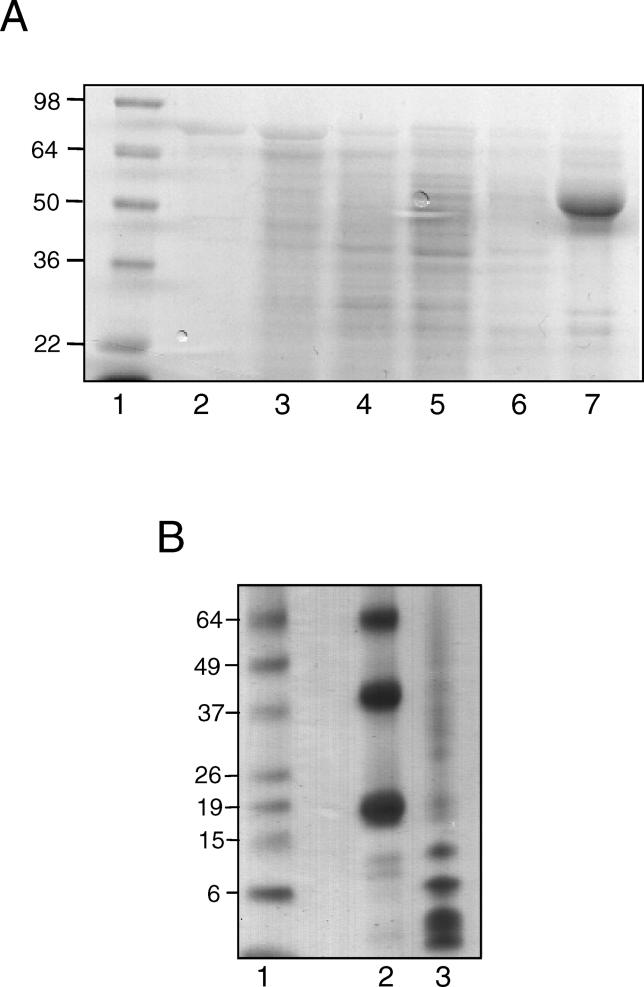
P. pastoris Secrete Ac-APR-1 Zymogen that Autoactivates at Low pH and Degrades Canine HbSDS-PAGE gel stained with Coomassie Brilliant Blue showing purification of recombinant APR-1 zymogen from P. pastoris culture supernatant.(A) Lane 1, molecular weight markers; lane 2, concentrated culture supernatant; lane 3, flow-through from a nickel-IDA column; lane 4, 5 mM imidazole wash; lane 5, 20 mM imidazole column eluate; lane 6, 60 mM imidazole eluate; and lane 7, 1 M imidazole eluate. Purified recombinant APR-1 zymogen was activated by buffer exchange into 0.1 M sodium formate/0.1 M NaCl (pH 3.6).(B) Lane 1, molecular weight markers; lane 2, 5.0 μg of canine Hb (pH 3.6); and lane 3, 5.0 μg of canine Hb (pH 3.6) incubated with 0.2 μg of recombinant APR-1.